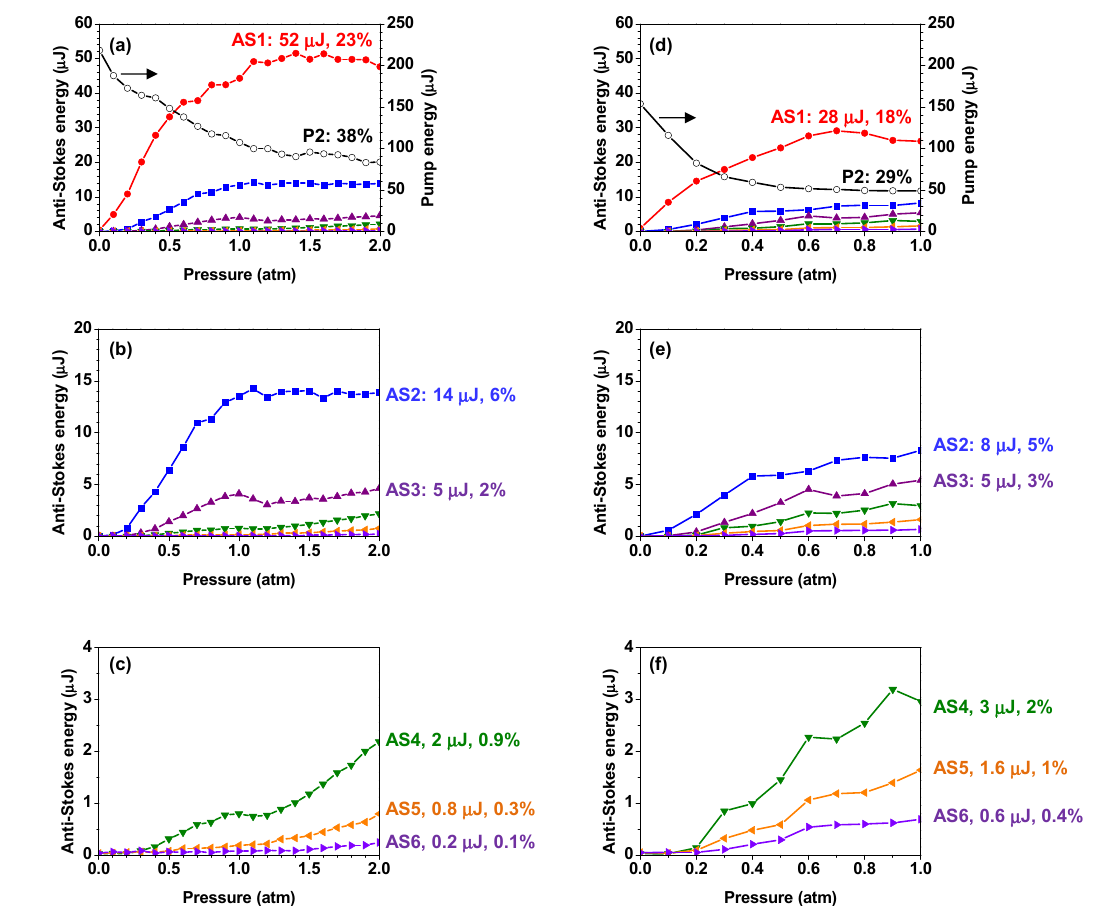
Figure 5. The pressure dependence of the energy for the output beams. ( a – c ) The gas cell and ( d – f ) the hollow fiber. The maximum energy obtained for each anti-Stokes emission is indicated together with the conversion efficiency from P2 to the anti-Stokes emission. For P2, the ratio of the output energy measured at a specified pressure and the output energy measured at 0 atm is listed in each panel.